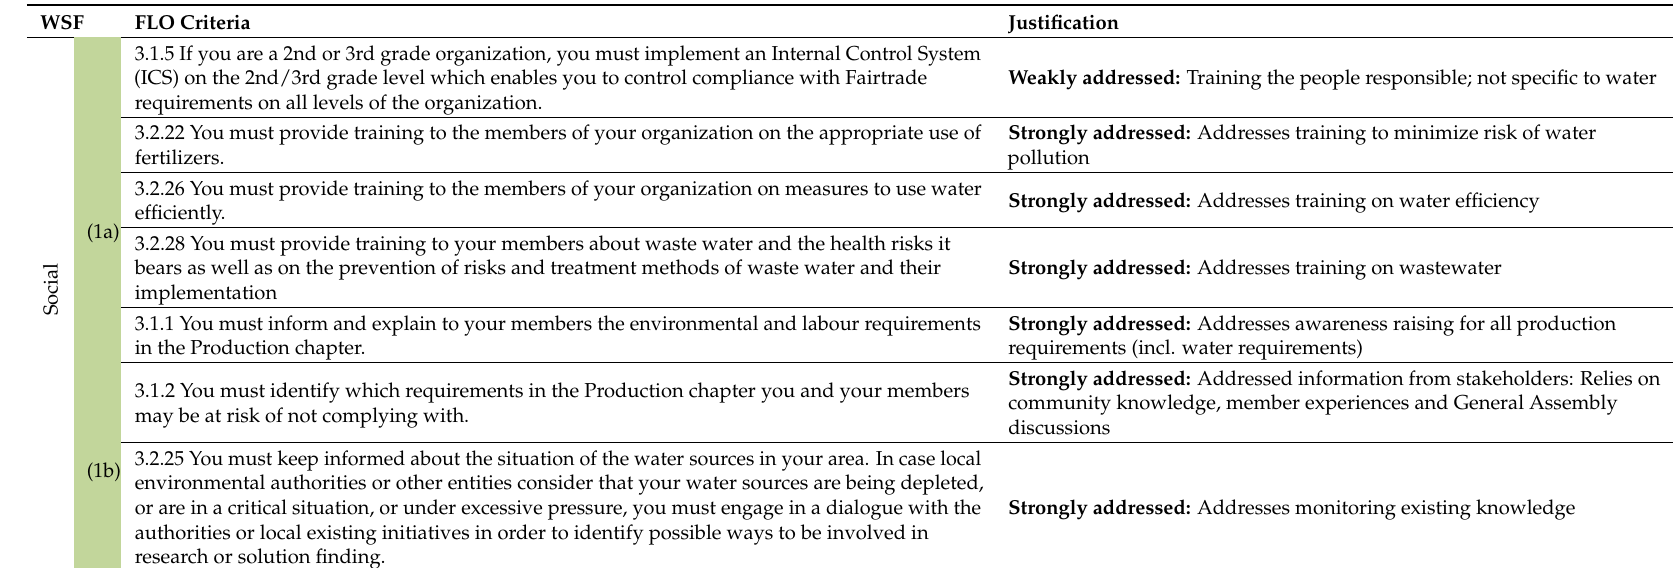
Table A6. Fairtrade Labelling Organization